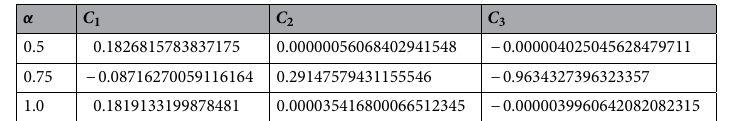
Table 2. Auxiliary convergence control parameters for different values of α for